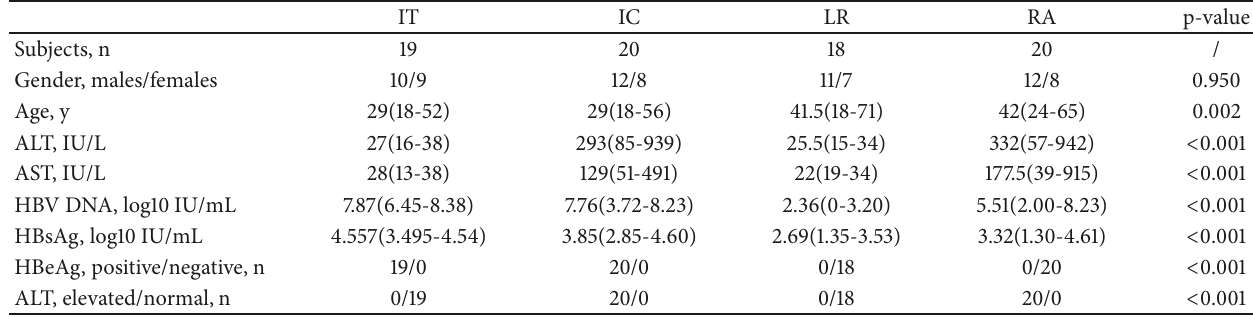
Table 2: Clinical characteristics of 4 subgroups of patients with chronic HBV